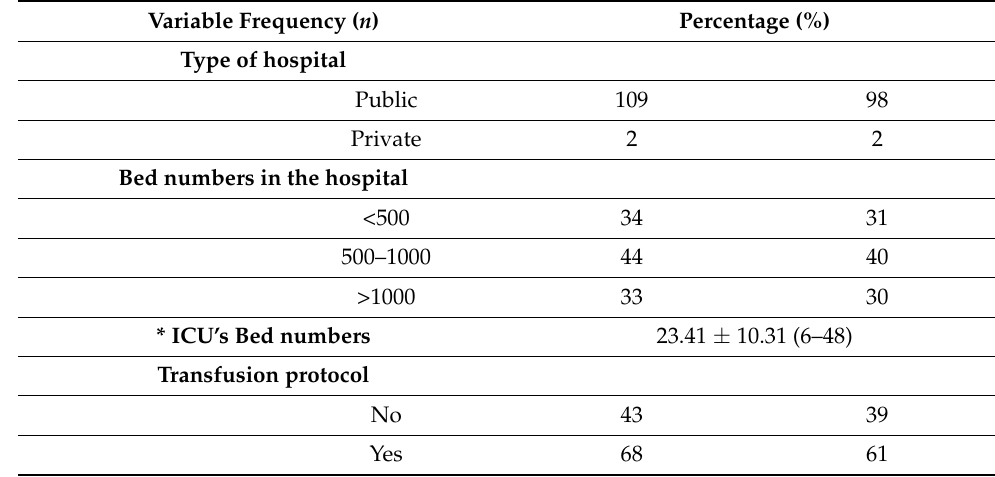
Table 2. Description of the ICUs participating in the